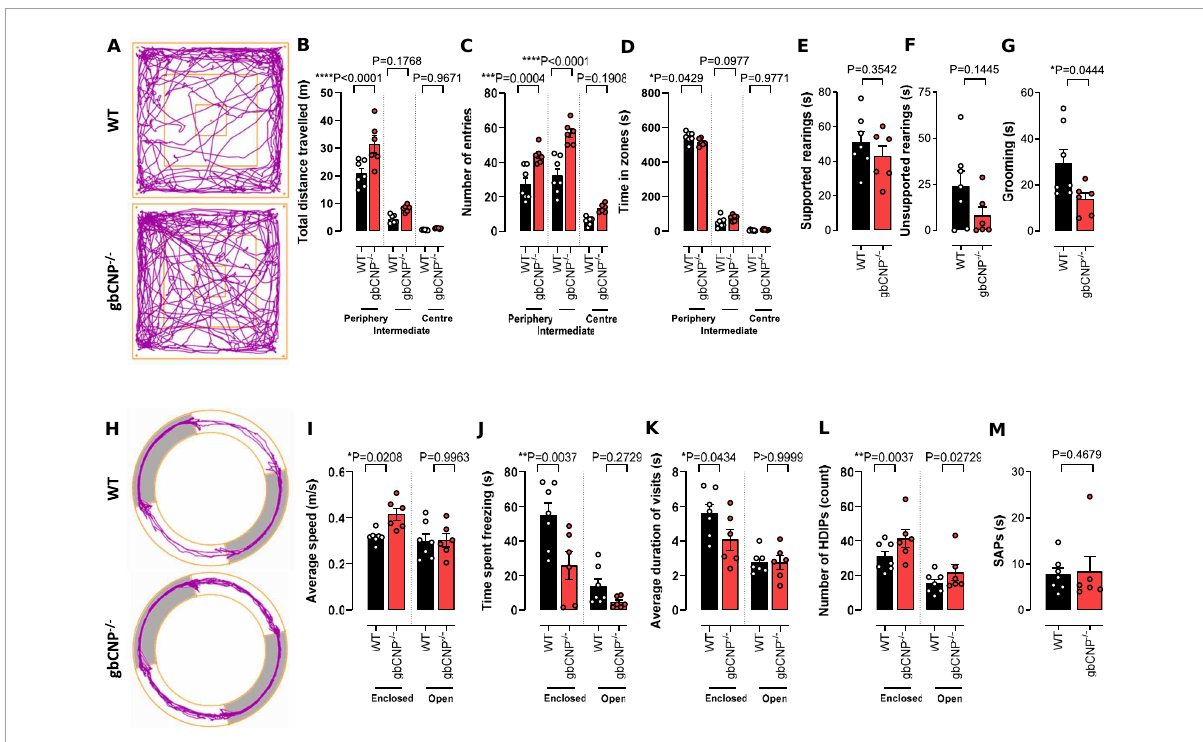
FIGURE3 Young adult gbCNP - / - mice were more active than their wild-type littermates in the open field and elevated zero maze. Open field analyses in wild-type (WT) and global CNP knockout (gbCNP - / - ) mice. Representative traces of movement of the mice in the apparatus (A) , total distance traveled (B) , number of entries in each zone of the open field (C) , time spent in each zone of the open field (D) , time spent on supported (E) and unsupported (F) rearings, and time spent grooming (G) . Elevated zero maze analyses in WT and gbCNP / mice: Representative traces of movement of the mice in the apparatus (H) , average speed (I) , time spent freezing (J) , average duration of the visits (K) , head dips (HDIPs) (L) and stretching attend postures ( SAPs, M) . n = 6-7. Statistical analysis by two-tailed Student’s t -test, Mann–Whitney U test or two-way analysis of variance with Šídák post hoc test. Each statistical comparison undertaken has an assigned P value (adjusted for